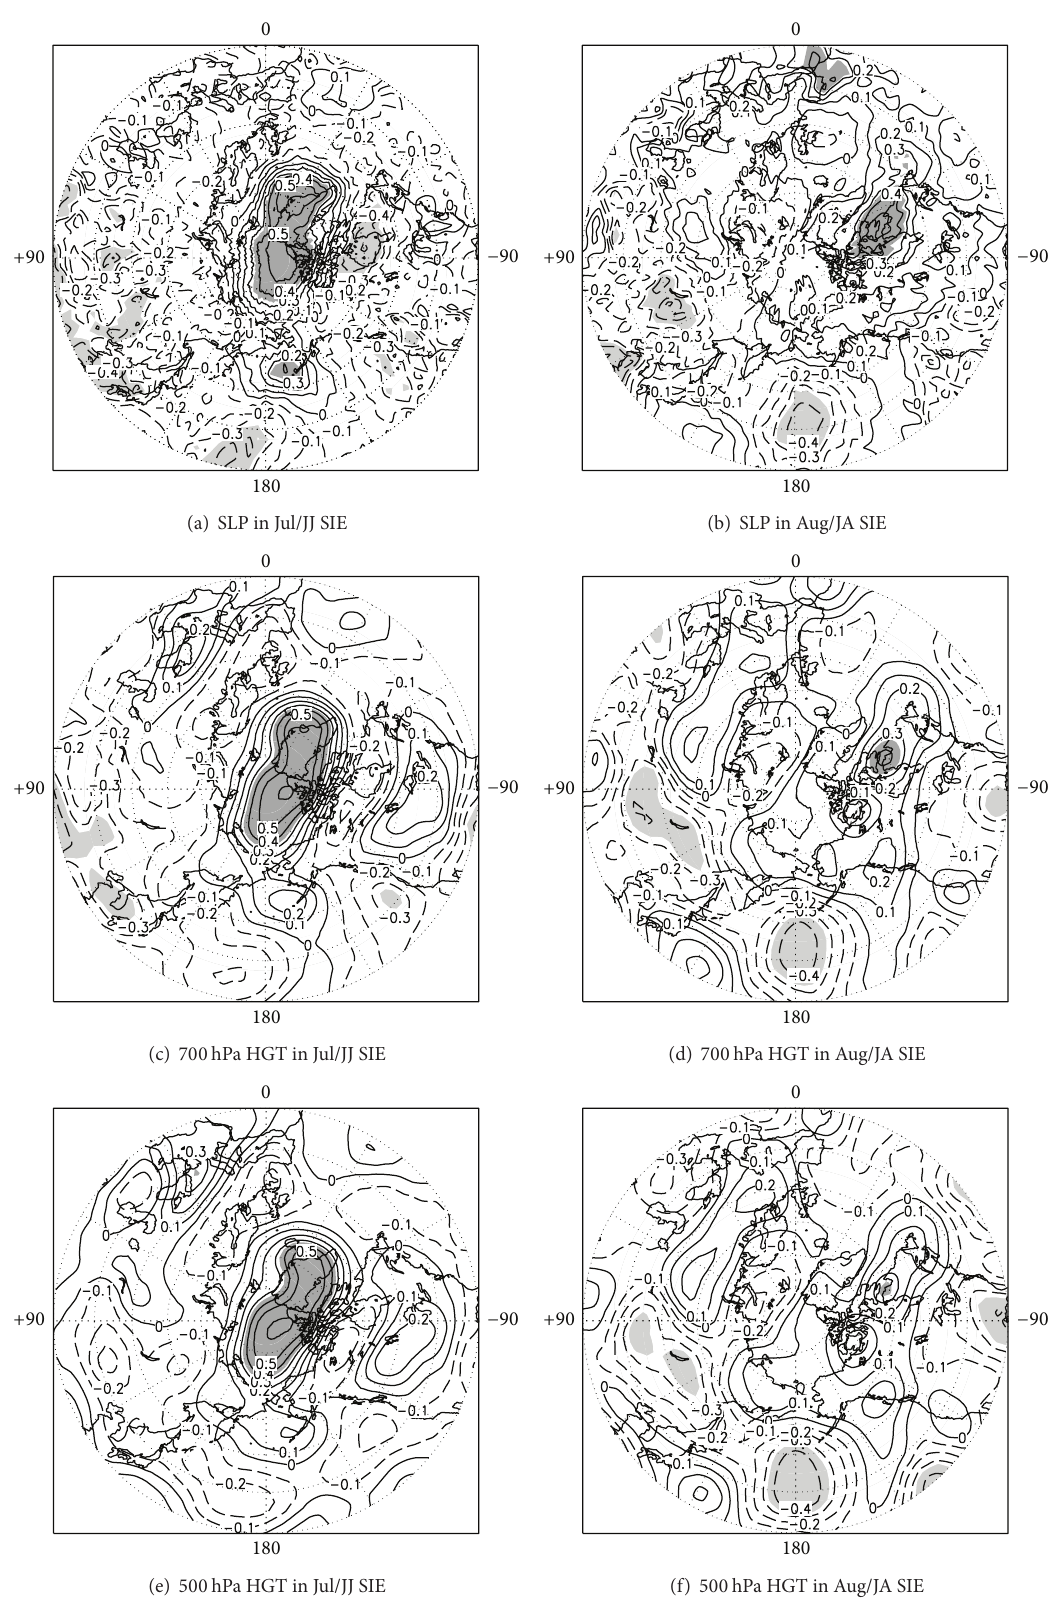
Figure 6: The correlation distribution between monthly surface level pressure (SLP) and 700 hPa and 500 hPa GHT over the north of 30 ∘ N in July and August and the monthly SIE differences for the JJ and JA after detrending: (a) July SLP and JJ SIE, (b) August SLP and JA SIE, (c) July 700 hPa GHT and JJ SIE, (d) August 700 hPa GHT and JA SIE, (e) July 500 hPa GHT and JJ SIE, and (f) August 500 hPa GHT and JA